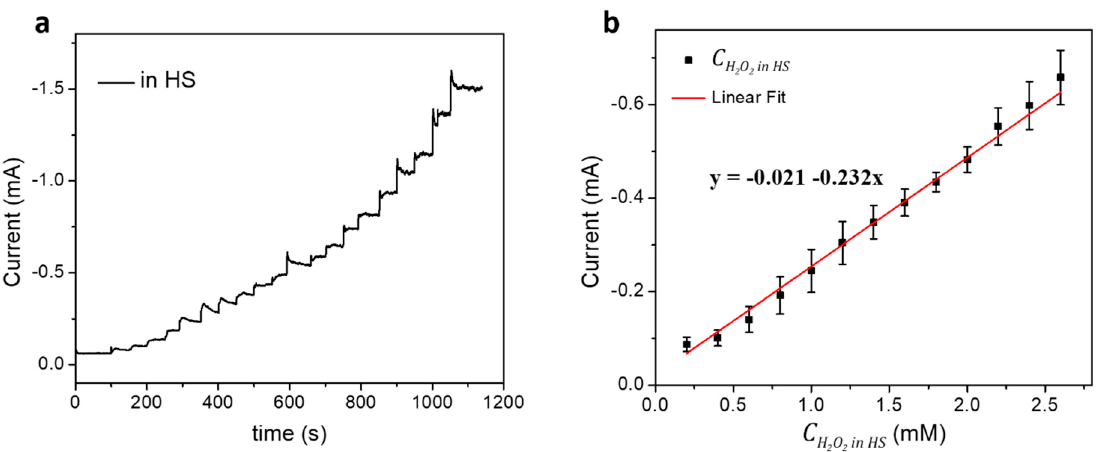
Figure 6. ( a ) CA ( I - t ) curves obtained for Hb / AgNF / ITO electrode upon successive additions of 10 µ L aliquots of 100 mM H 2 O 2 in human serum (HS) to 5 mL of 10 mM PBS with constant stirring (1200 rpm) at an applied potential of − 0.5 V vs. Ag / AgCl under nitrogen purging. ( b ) Calibration curve showing the concentration of H 2 O 2 in HS plotted vs. the measured catalytic peak current; data points express mean ± SD of three replicated measurements and the fitted curve represents a linear fit equation.